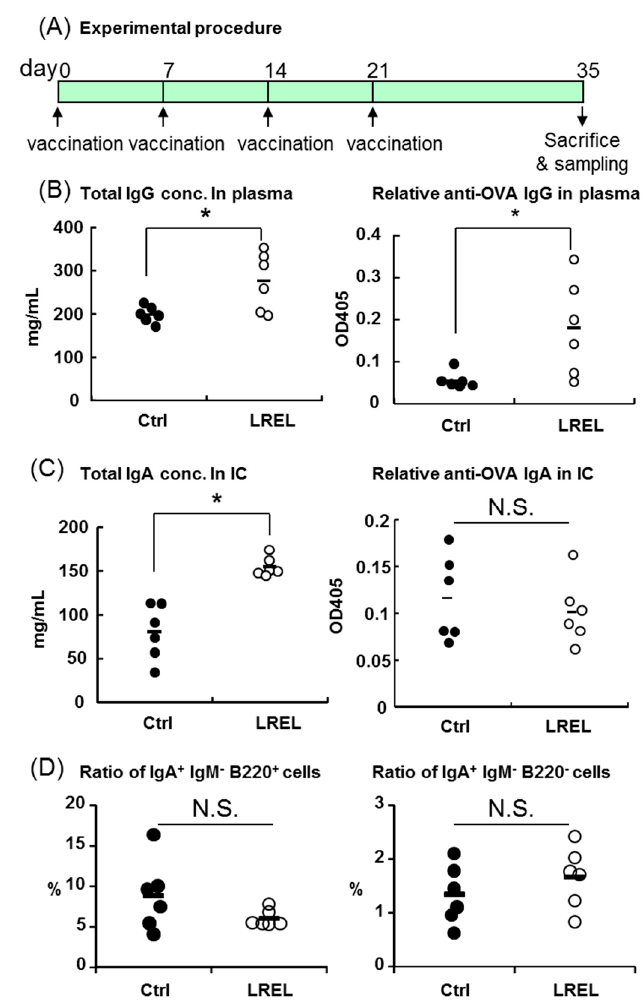
Figure 5. Systemic IgG and mucosal IgA induction by oral LREL stimulation in combination with OVA. ( A ) Experimental procedure of LREL and OVA vaccination. Healthy BALB/C mice were divided into the control and LREL groups ( n = 6) and vaccinated with 1 mg of OVA with/without 1 mg LREL once a week (day 0, 7, 14 and 21), and all mice were sacrificed two weeks after the final vaccination (day 35). ( B ) Total IgG concentration in plasma (left panel) and relative concentration of anti-OVA IgG in plasma (right panel). Total IgG and anti-OVA IgG in plasma were significantly increased in the LREL group. ( C ) Total IgA concentration in the intestinal contents (left panel) and relative concentration of anti-OVA IgA in the intestinal contents (right panel). Total IgA concentration in the intestinal contents was significantly increased in the LREL group, while anti-OVA IgA concentration was not changed between the control and LREL group. ( D ) Comparison of the ratio of IgA + B cells in Peyer’s patches. Both the ratio of IgA + IgM − B220 + cells (left panel) and IgA + IgM − B220 − cells (right panel) was not significantly changed between two groups. The short line in ( B – D ) represents the mean value ( n = 6). * p < 0.05 compared to the control (Student’s t test). These data are representative of two independent experiments.